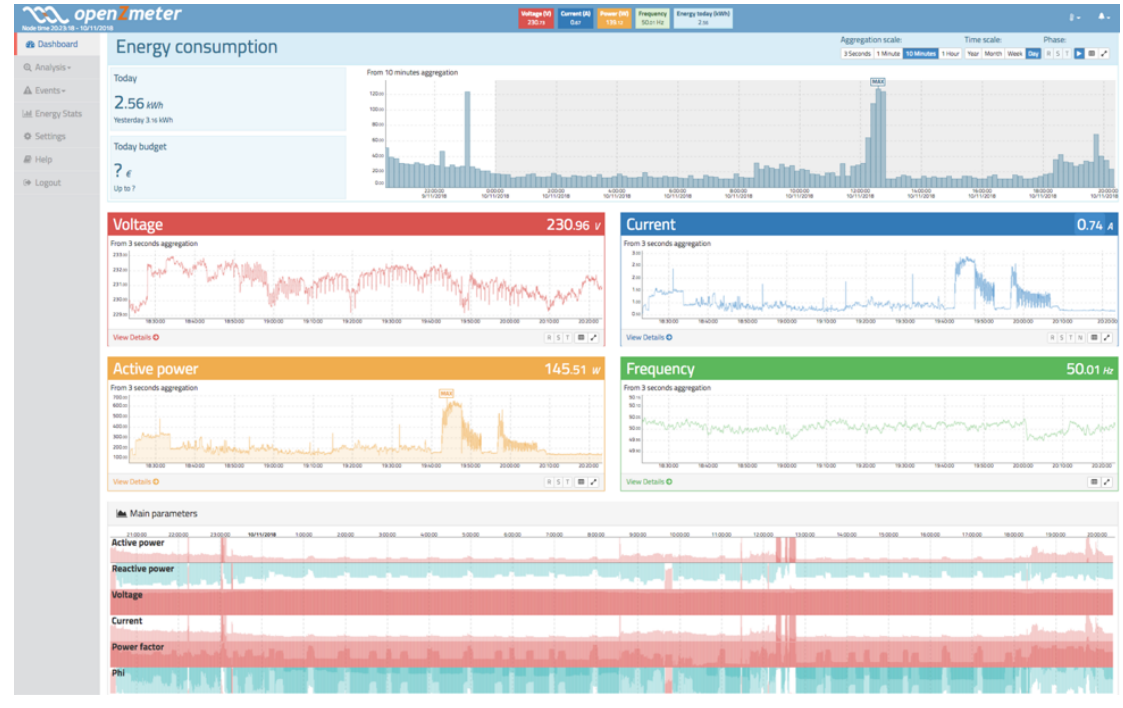
Figure 6. Dashboard of real-time power quality (PQ) monitoring and smart-metering